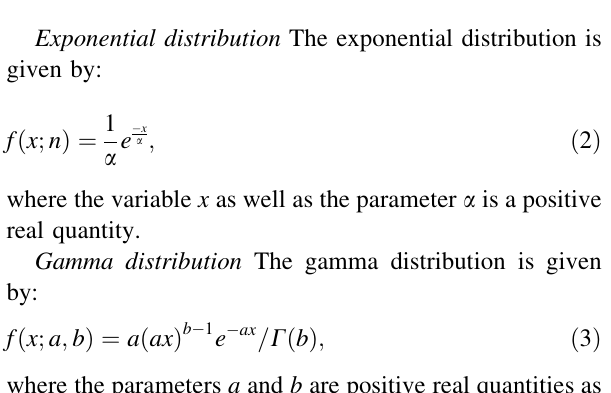
Fig. 2 Annual time series of